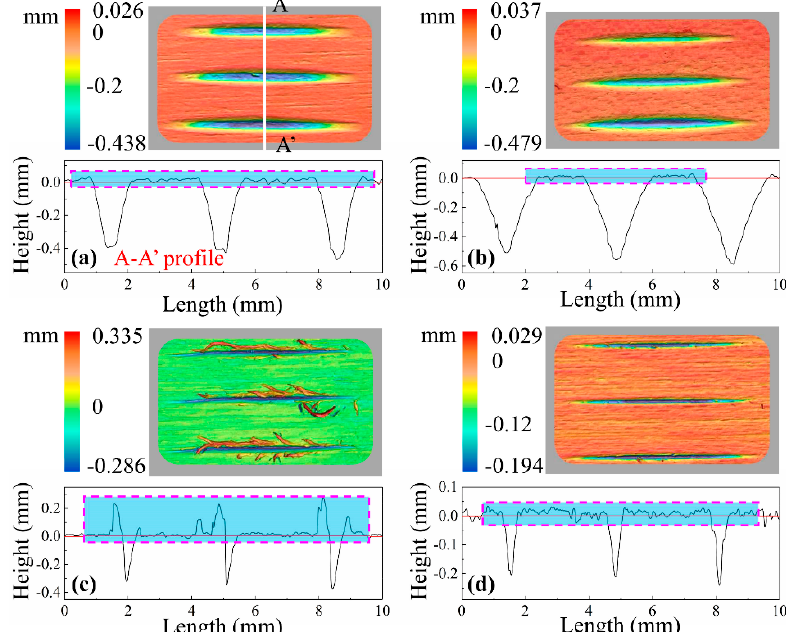
Figure 4. 3D morphology and 2D cross-sectional profiles of typical scratches ( λ = 0 ° ) cut by: ( a ) spherical cone tool with 2 α = 84 ° , ( b ) spherical cone tool with 2 α = 108 ° , ( c ) triangular pyramid tool with one main cutting edge and two side cutting edges, and ( d ) triangular pyramid tool with two main cutting edges. Note: the 2D cross-sectional profiles were extracted from the deepest point of the scratch like the A-A’ profile.